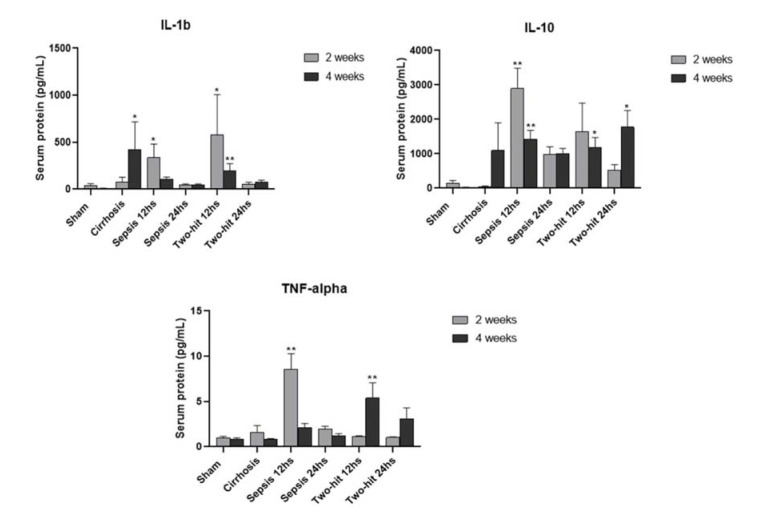
Cytokine levels in the experimental groups (mean serum protein concentrations ± SEM). p<0.0001 for comparison between all groups. *p<0.05, **p<0.01 for comparisons against the sham group (respective week).